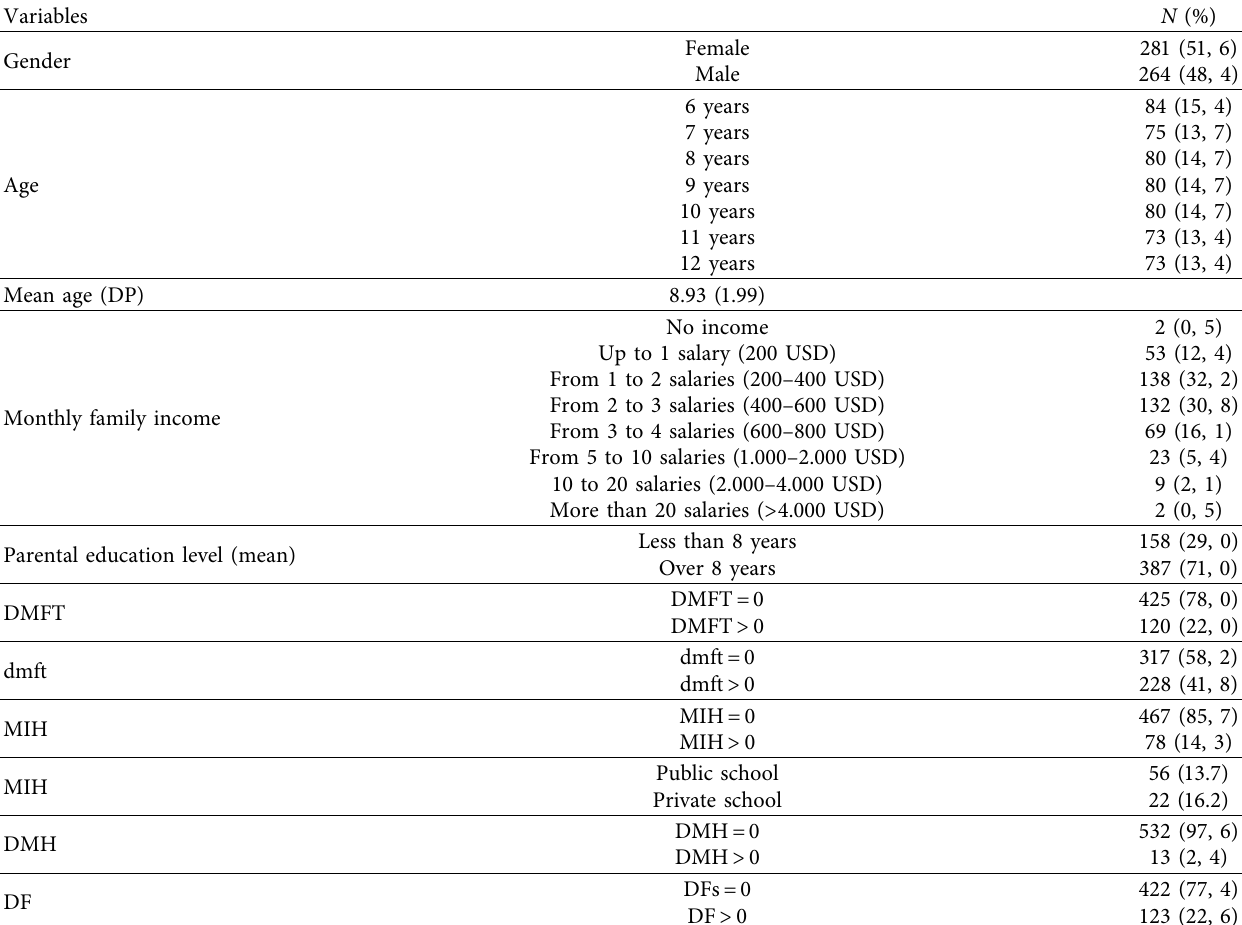
Table 1: Demographic data of the study population.